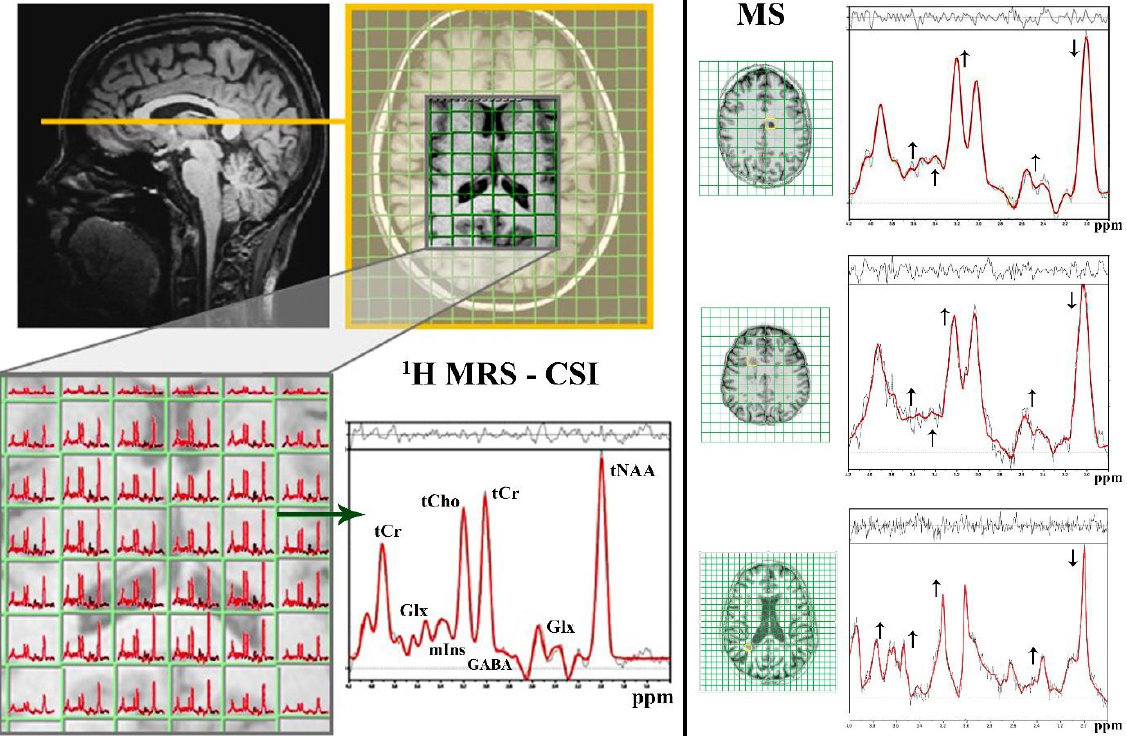
Figure 1. Visualization of proton-1 magnetic resonance spectroscopy ( 1 H MRS). 1 H MRS examination of brain tissue by using the multivoxel spectroscopy ( 1 H magnetic resonance spectroscopic imaging (MRSI)–chemical shift imaging (CSI)) approach with the representing spectra (one CSI voxel indicated with the green arrow) containing metabolite peaks for total creatine (tCr), total choline (tCho), total N-acetyl-aspartate (tNAA), glutamate and glutamine (Glx), γ-aminobutyric acid (GABA), and total myoInositol (mIns). The 1 H MRS spectra for the healthy (on the left) and MS-affected (on the right) brain are also depicted together with the highlight of the typical metabolic peaks changes via small black arrows ( ↓ : decreased, ↑ : increased).